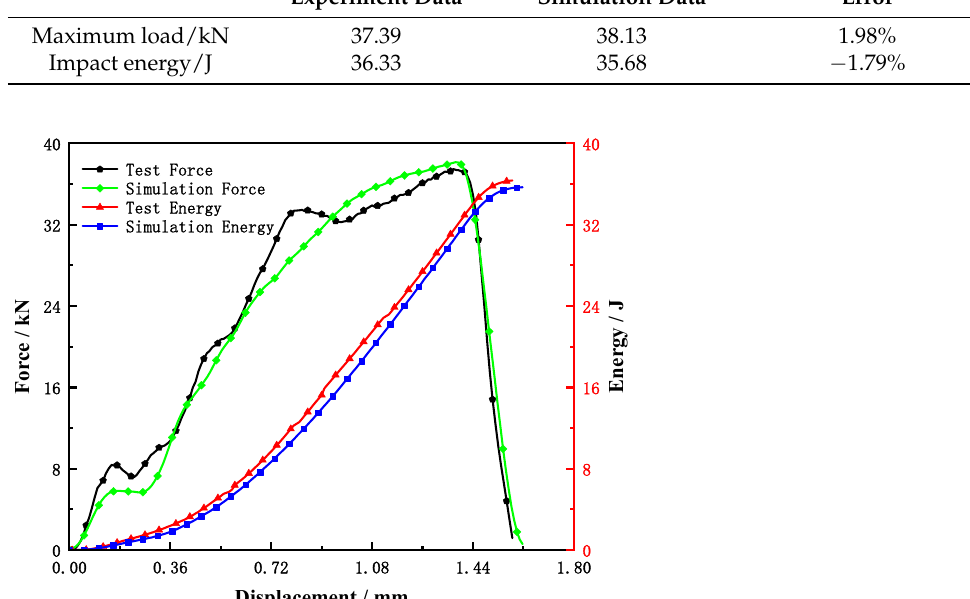
Figure 11. FE model of Charpy impact test.